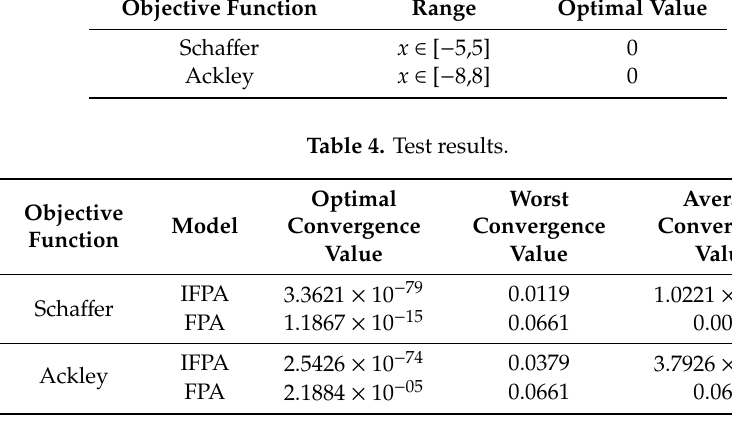
Figure 4. Flowchart of the improved flower pollination algorithm–feedforward (IFPA–FF) prediction model.